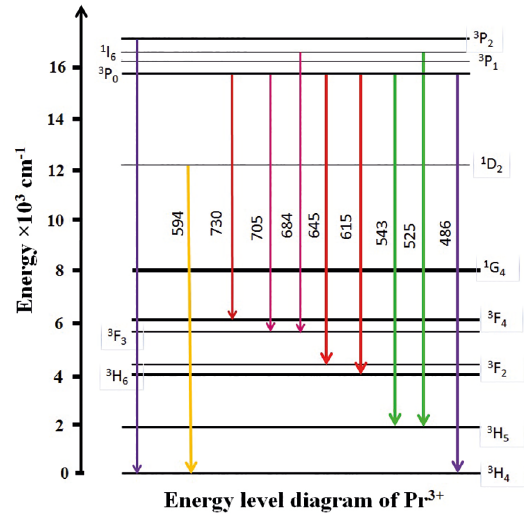
Figure 8. proposed energy level diagram of Pr(III)